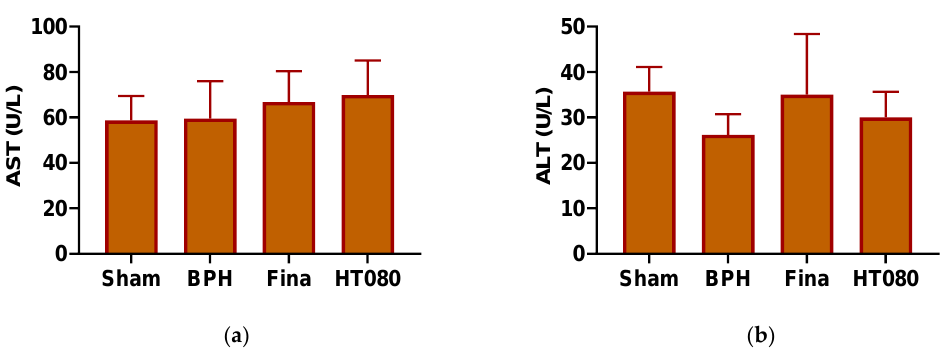
Figure 5. Levels of serum AST ( a ) and ALT ( b ) in sham, BPH, finasteride (Fina), and HT080 groups. Values are expressed as mean ± S.D.